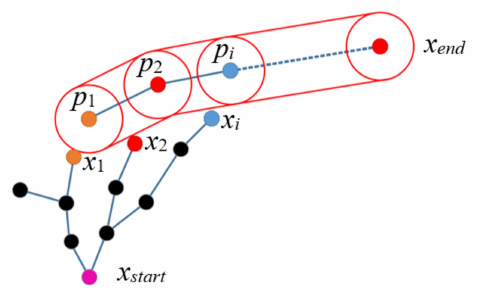
Figure 13. Different connection node